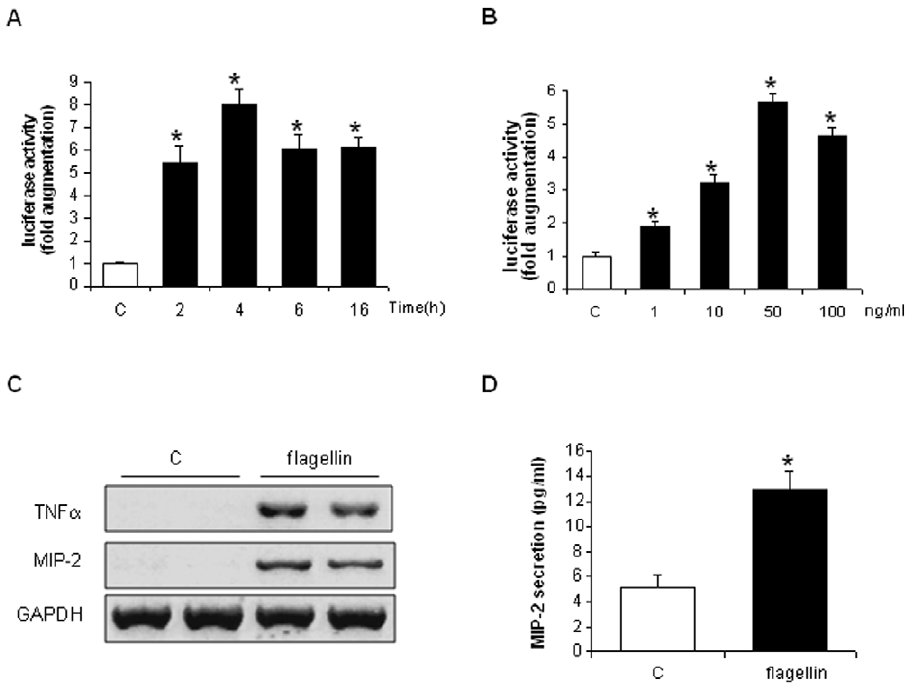
Figure 4. Transcription of NF- k B-dependent genes in H9c2 cells after flagellin challenge. A, Time-course experiments. Luciferase activity was maximally induced after 2 to 4 hours of flagellin (50 ng/ml). B, Dose-response experiments. Luciferase activity was slightly induced by 1 ng/ml flagellin and maximally induced by 50 ng/ml flagellin (4 hours). C, Transcript levels of TNF a and MIP-2 mRNA (RT-PCR) in unstimulated cells (control, C) and after flagellin (50 ng/ml, 1 hour). GAPDH, control. D, Flagellin induced synthesis and secretion of MIP-2 by H9C2 cells (ELISA). * p , 0.05 versus control C (ANOVA followed by Dunnett test A and B; t -test, D).